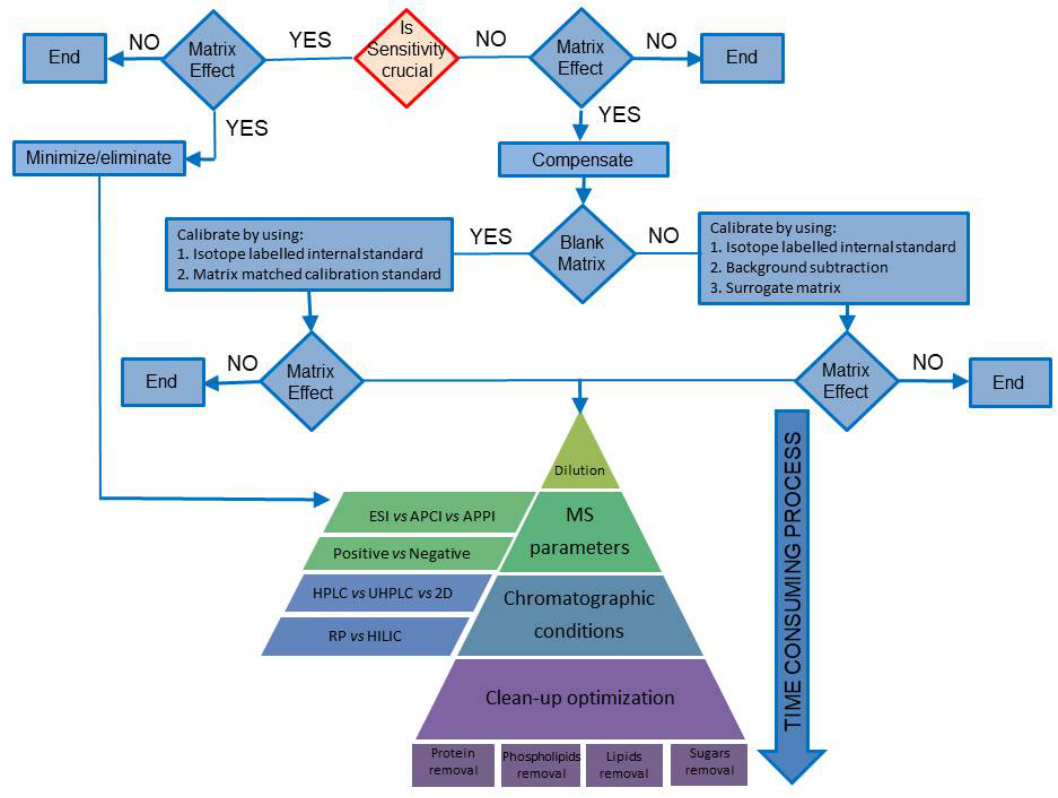
Figure 1. Flow chart of the reviewed methodologies to evaluate and overcome the matrix effect .